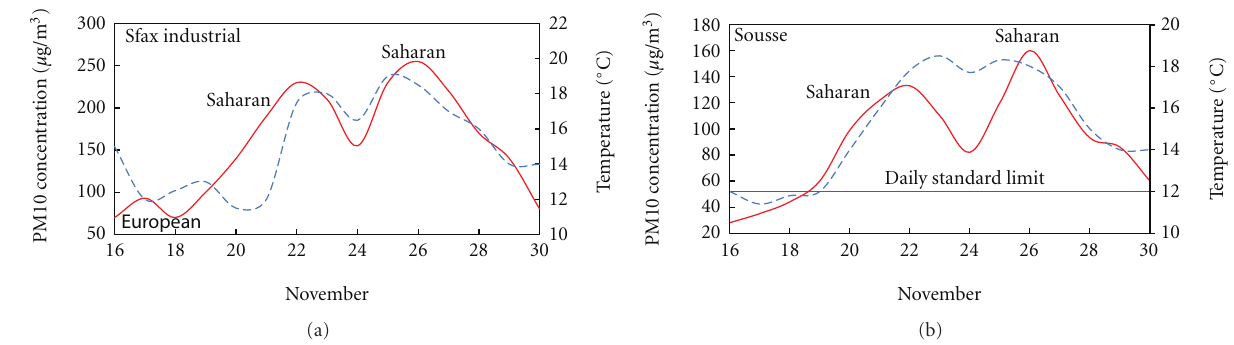
Figure 7: Daily variability of samples of the PM10 concentrations and temperature during winter in the selected monitoring stations. Time evolution of the left y axis is plotted with solid line, and the right one is plotted with dashed line. (Solid and dashed lines are smooth curve fits).